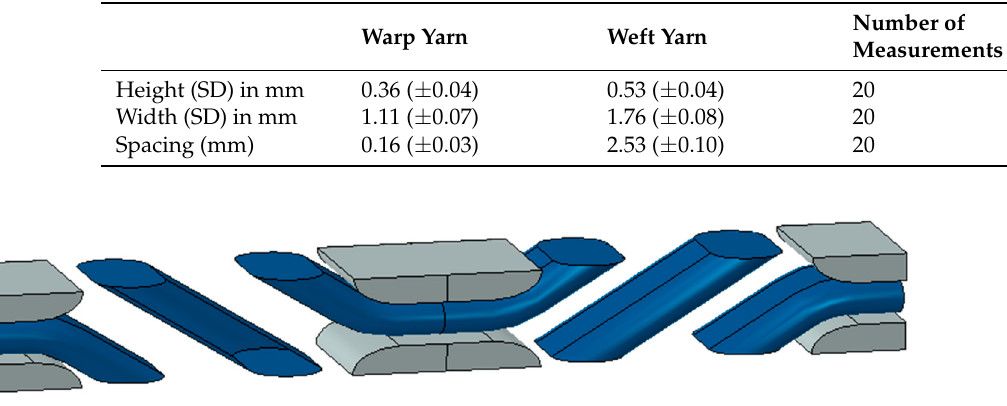
Figure 3. A geometric model of the unit cell with matrix being hidden.